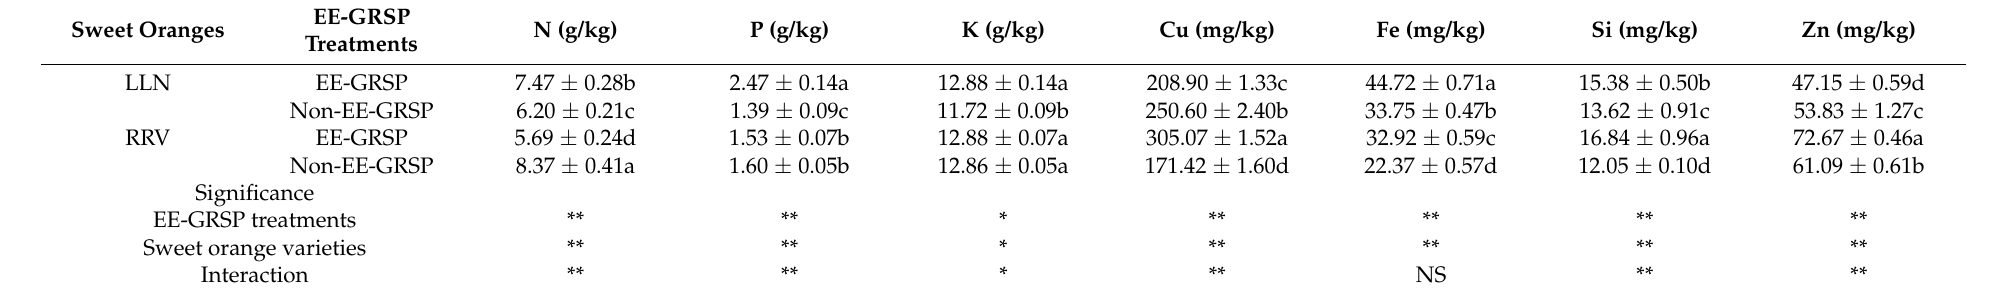
Table 4. Application response of exogenous EE-GRSP on the mineral composition of fruit pulp of late-ripening sweet